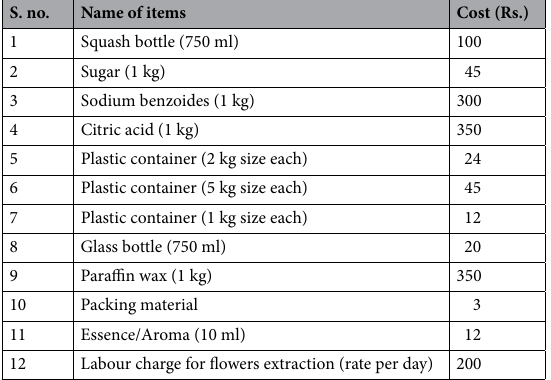
Table 2. Market cost in rupees (Rs.) of essential commodity in the preparation of R. arboreum juice/squash in Garhwal